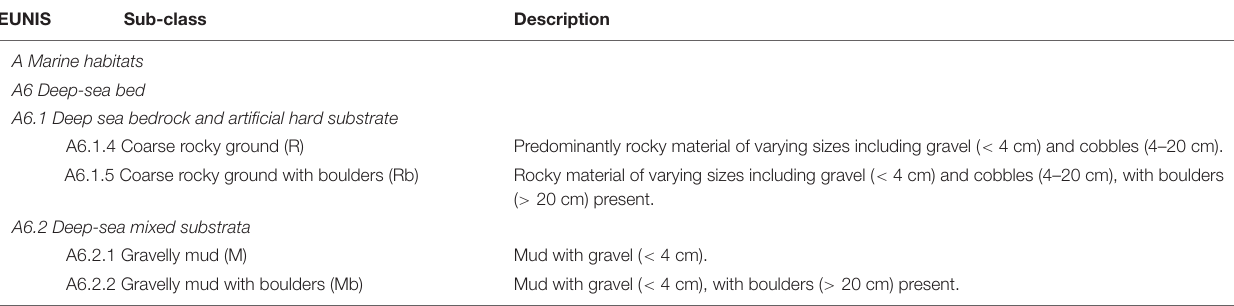
TABLE 2 | Substrate classes used to label images sampled from videos. Substrate classes are based on the revised EUNIS Habitat Classification (Davies et al., 2004), as adapted by Gougeon et al. (2017) and further modified here. EUNIS